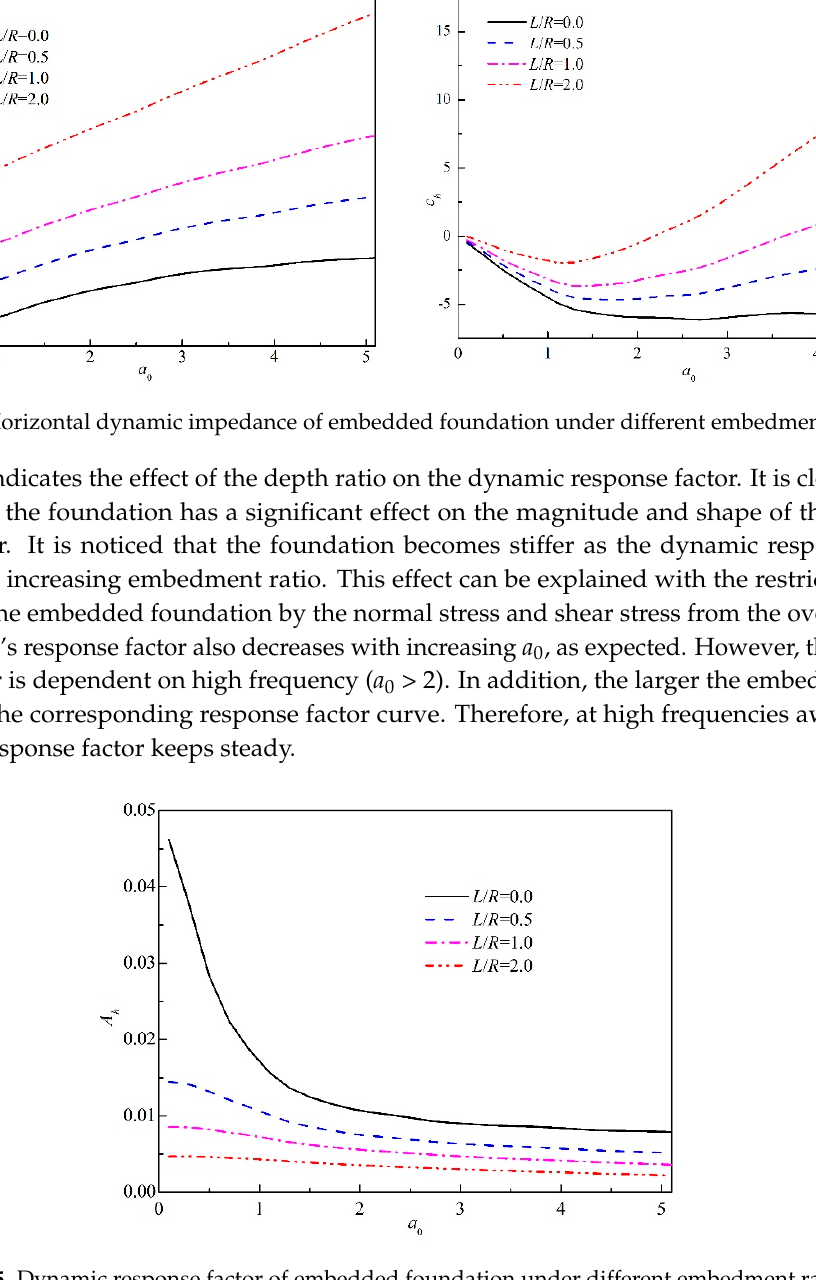
Figure 5. Dynamic response factor of embedded foundation under different embedment ratio.